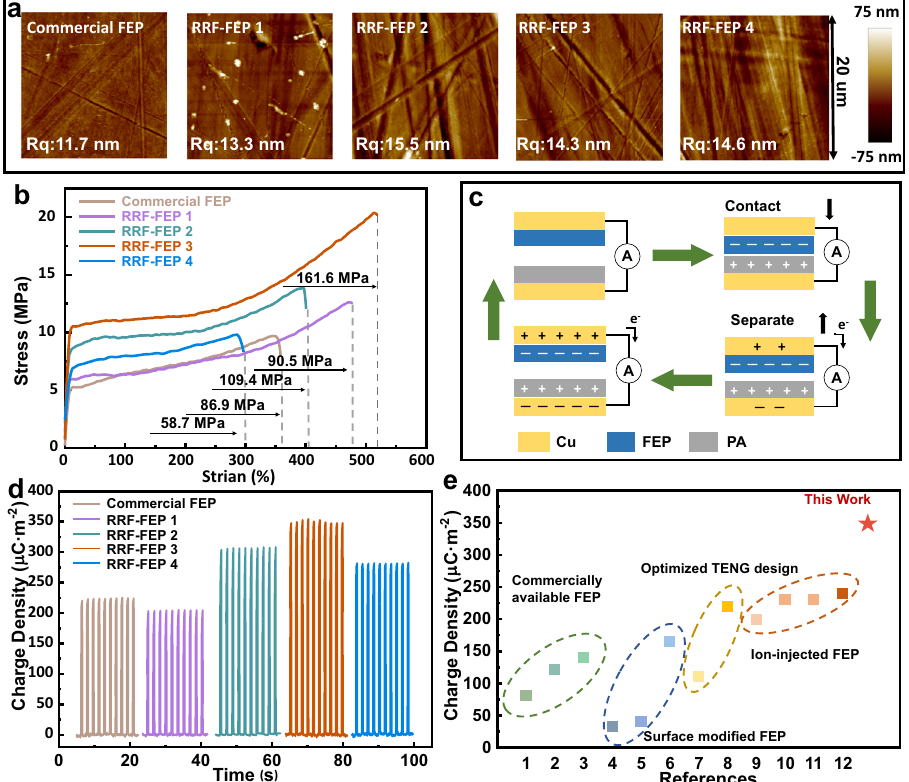
Fig. 2 High performance demonstration of RRF-FEP compared with commercial FEP. a The surface morphology of commercial FEP and RRF-FEP observed by atomic force microscope (AFM) ( b ) Stress vs strain curves of each sample during tensile deformation. c Schematic diagram of measurement method in experiment with FEP samples. d Maximum saturated charge density between FEP and PA measured by contact-separation TENG. e Saturated charge density comparison in the previous works of the TENG. Source data are provided as a Source Data fi le. NATURE COMMUNICATIONS| (2022) 13:4083